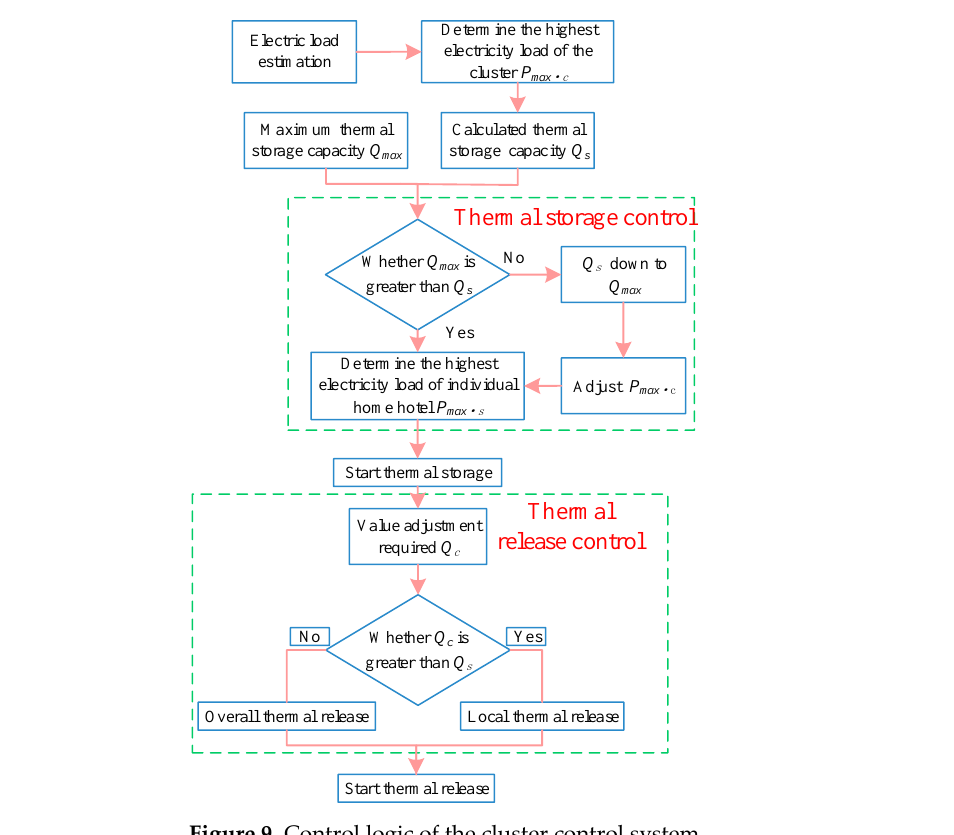
Figure 9. Control logic of the cluster control